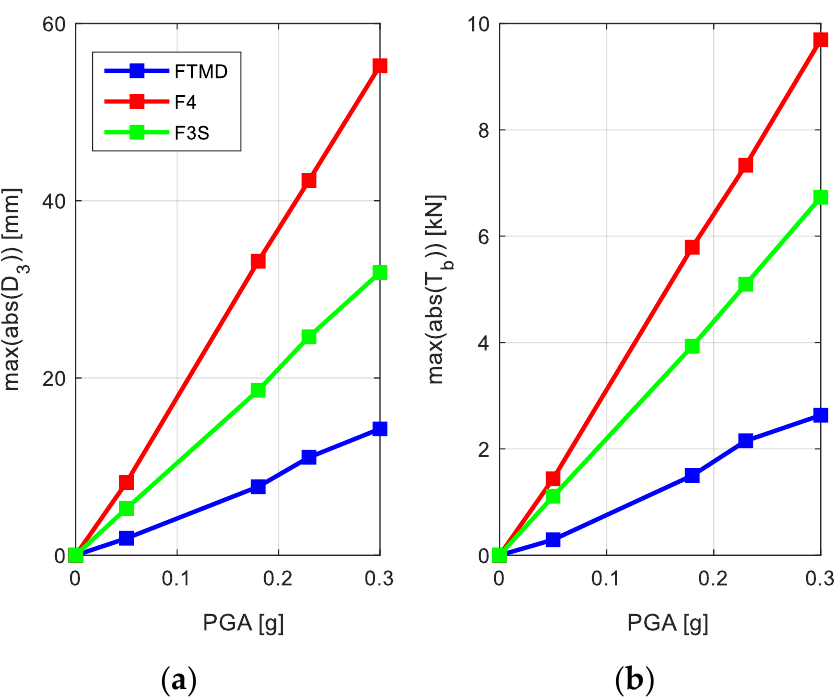
Figure 17. NE— Kobe earthquake, configurations compared: FTMD, F4, F3S, ( a ) maximum value of the third floor displacement D 3 versus PGA ( b ) maximum value of the base shear T b versus PGA.